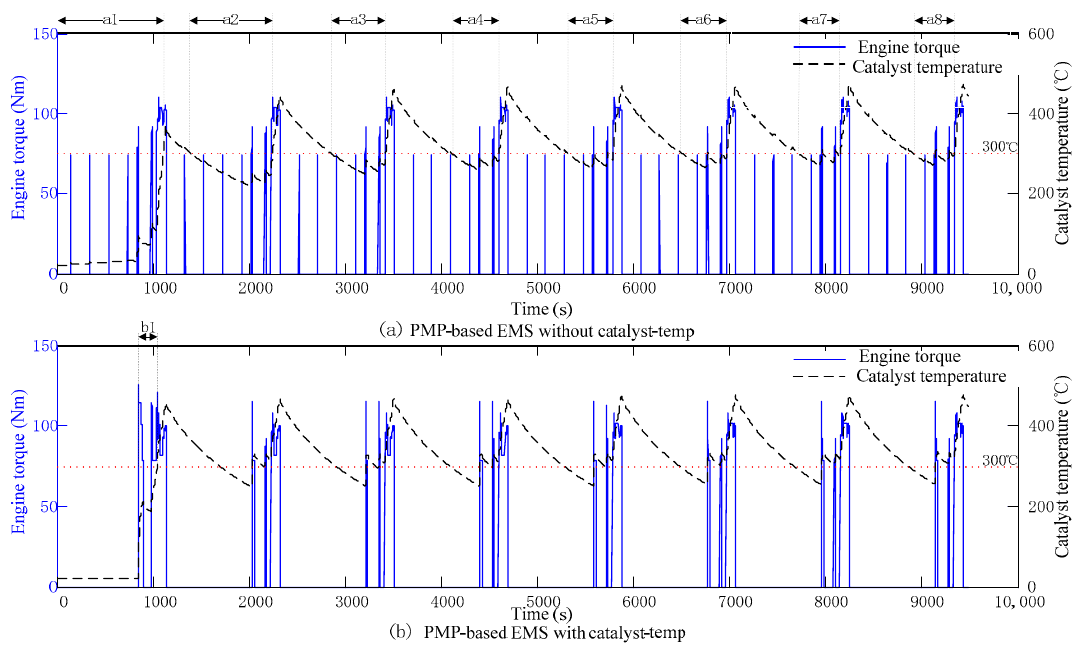
Figure 15. Comparison of simulation results under eight repeated New European Driving Cycle (NEDC) for different energy management strategies (EMSs).